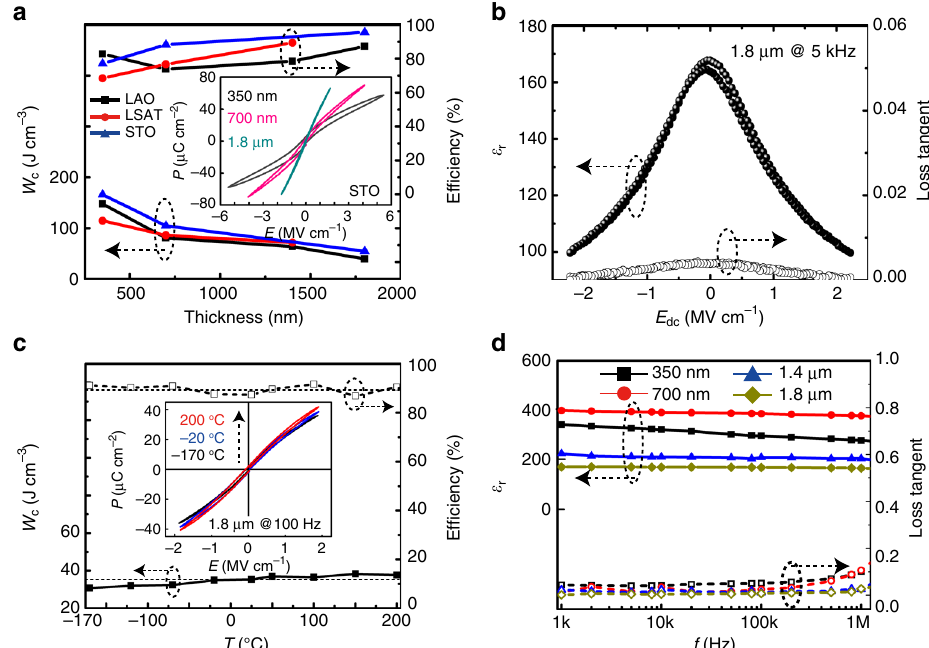
Fig. 4 Electrical energy storage capability and dielectric stability. a Thickness-dependent energy storage densities and ef fi ciencies ( W C and η ) of the BZT fi lms grown on different substrates, the inset shows the typical P – E loops. b Room temperature ε c W C and η as functions of temperature for the fi lm in b , computed from its temperature-dependent P – E loops (inset). d Room temperature ε r – f and tg δ – f curves for BZT fi lms grown on the same substrates (LAO) but with different